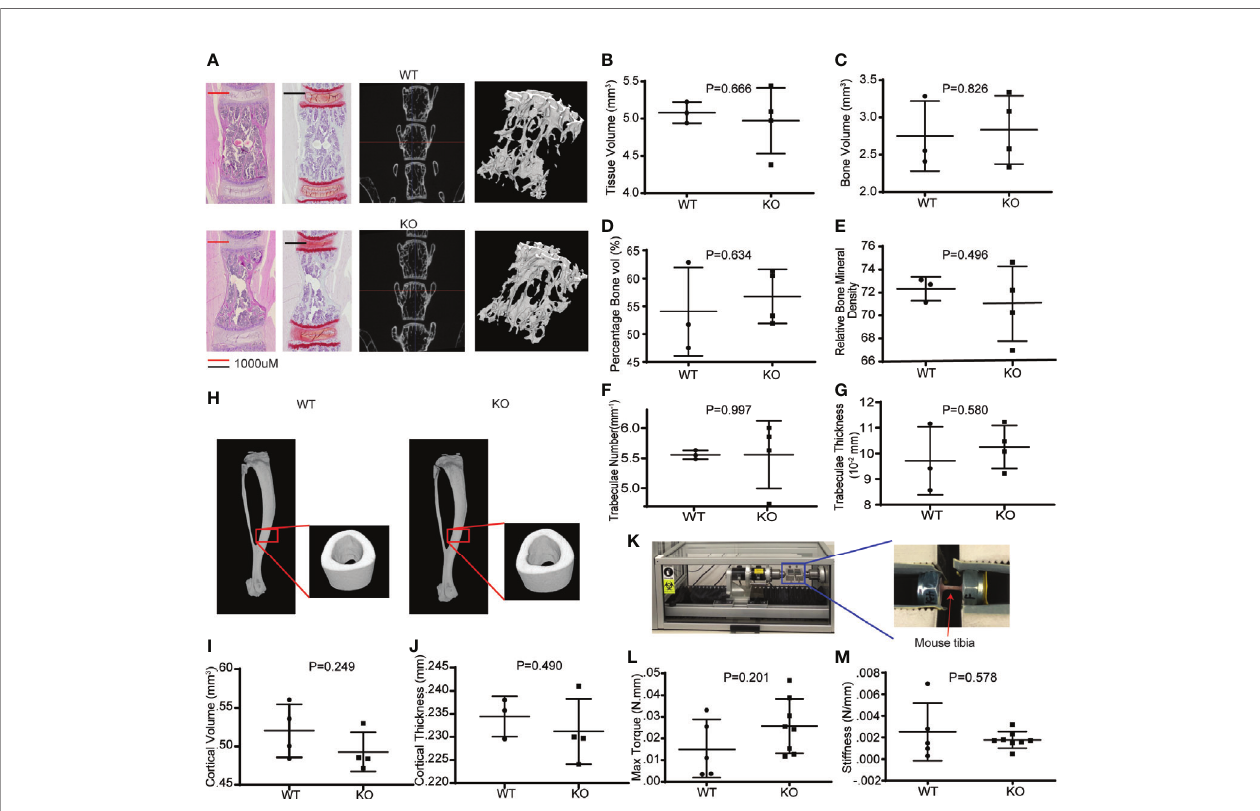
FIGURE 4 | Hematopoietic Wnt-depleted mice have normal bone quality. (A) L5 vertebral bodies from WT and KO mice assessed by hematoxylin and eosin (H&E) and safranin O staining and micro computer-assisted tomography ( m CT) with reconstruction demonstrating similar trabecular bone microarchitecture. (B – G) m CT quanti fi cation revealed no major differences in the bone quality of the L5 vertebrae by tissue volume (mm 3 ), bone volume (mm 3 ), percentage bone volume (%) and relative bone mineral density, trabaculae number(mm -1 ) and trabaculae thickness in the KO and WT mice. (H) m CT reconstruction of tibia cortical bone demonstrated minimal difference in (I) cortical volume (mm 3 ), and (J) cortical thickness (mm) between the KO and WT mice. (K) Rotational torque machine. (L) The maximum tibia torque and (M) 4-point bending stiffness (Newton/mm) of the tibia were similar for both groups of